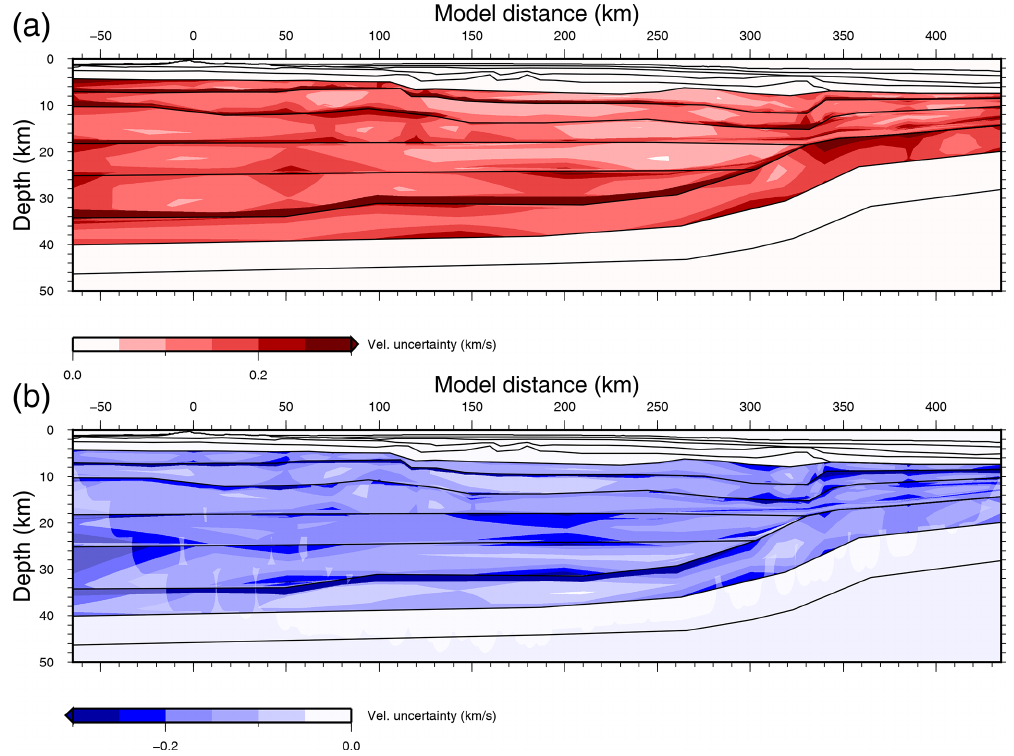
Figure 12. Global uncertainty plots for MZ3. (a) Maximum and (b) minimum admissible velocity deviations from the preferred model, built from 126 models within the thresholds defined in the text. Shaded areas indicate ray coverage. Preferred model interfaces are indicated by black